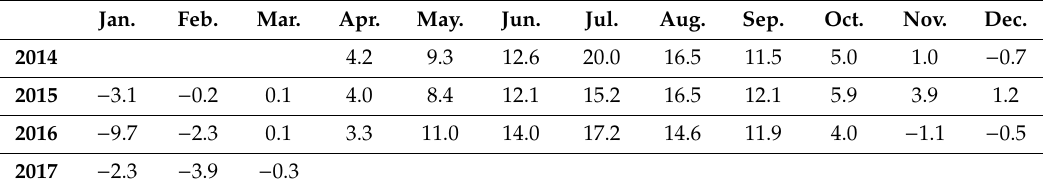
Table 2. The timetable for the measurements, between April 2014 and March 2017; the number of days between two measurements ( Δ t ), and the time t [day] since the beginning of the measurements (used as the x -axis in Figures 3–6).